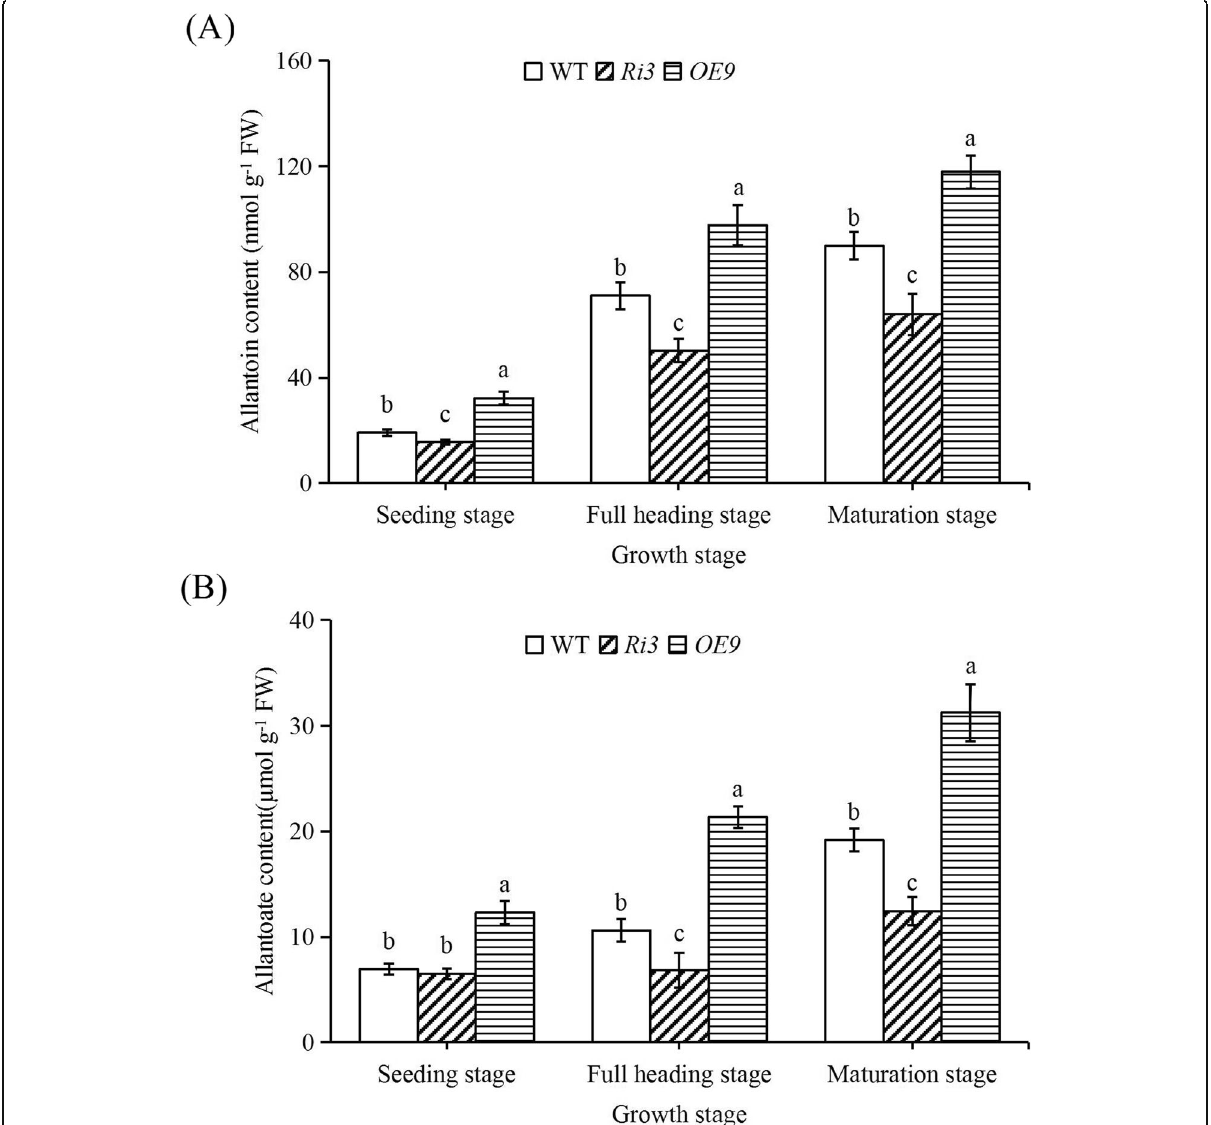
Fig. 6 Allantoin and allantoate content in wild-type and transgenic lines at different growth stages. The seedling, full heading and maturation stages of rice were grown to 14d, 60d, and 90d after sowing, respectively. The penultimate leaves were selected at seedling stage, and sword leaves are selected for the determination of allantoin ( a ) and allantoate ( b ) content at full heading and maturation stages. FW, fresh weight. Values are means±SEM, n = 3. Significant differences ( P < 0.05) are denoted by different lowercase